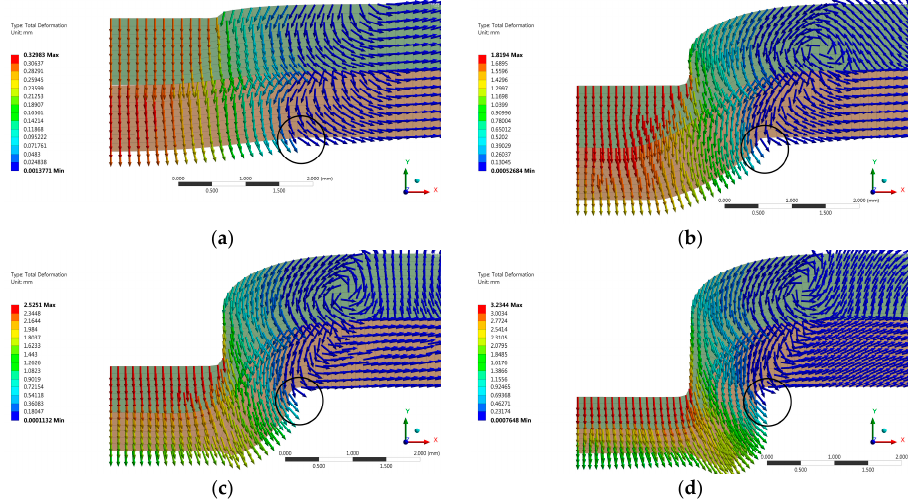
Figure 12. Total deformation of both sheets in the individual joint forming process stages (the circle indicates the ROD area): ( a ) drawing phase; ( b ) compression phase; ( c ) interlocking phase; ( d ) backward extrusion phase.